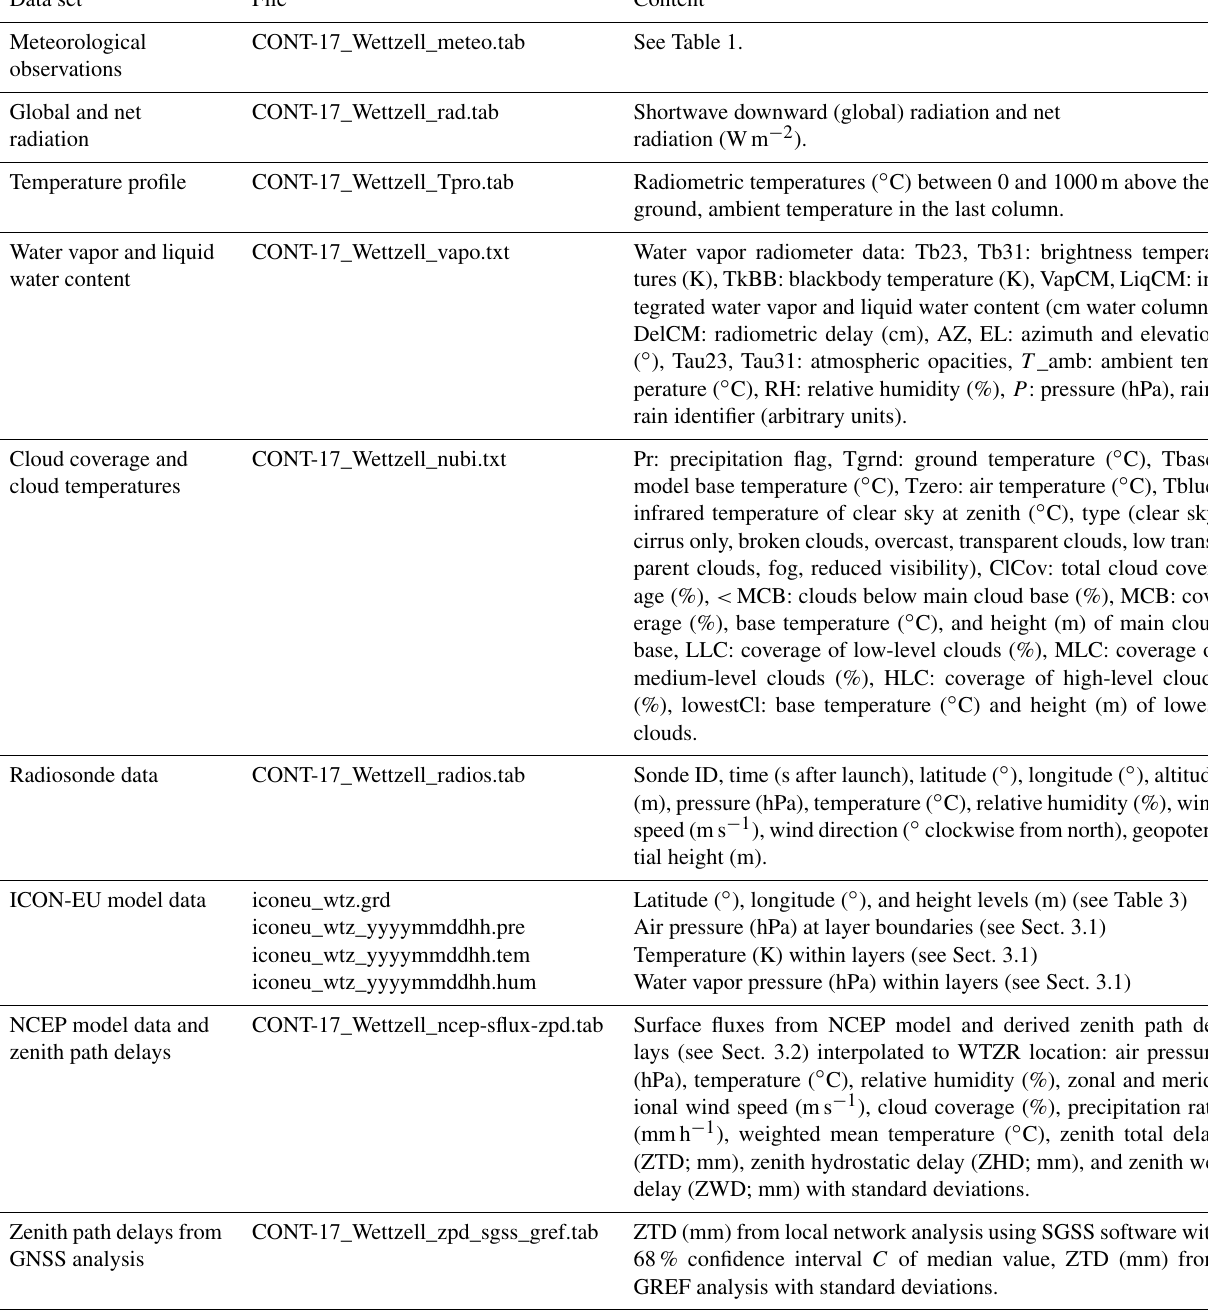
Table 5. Description of the data